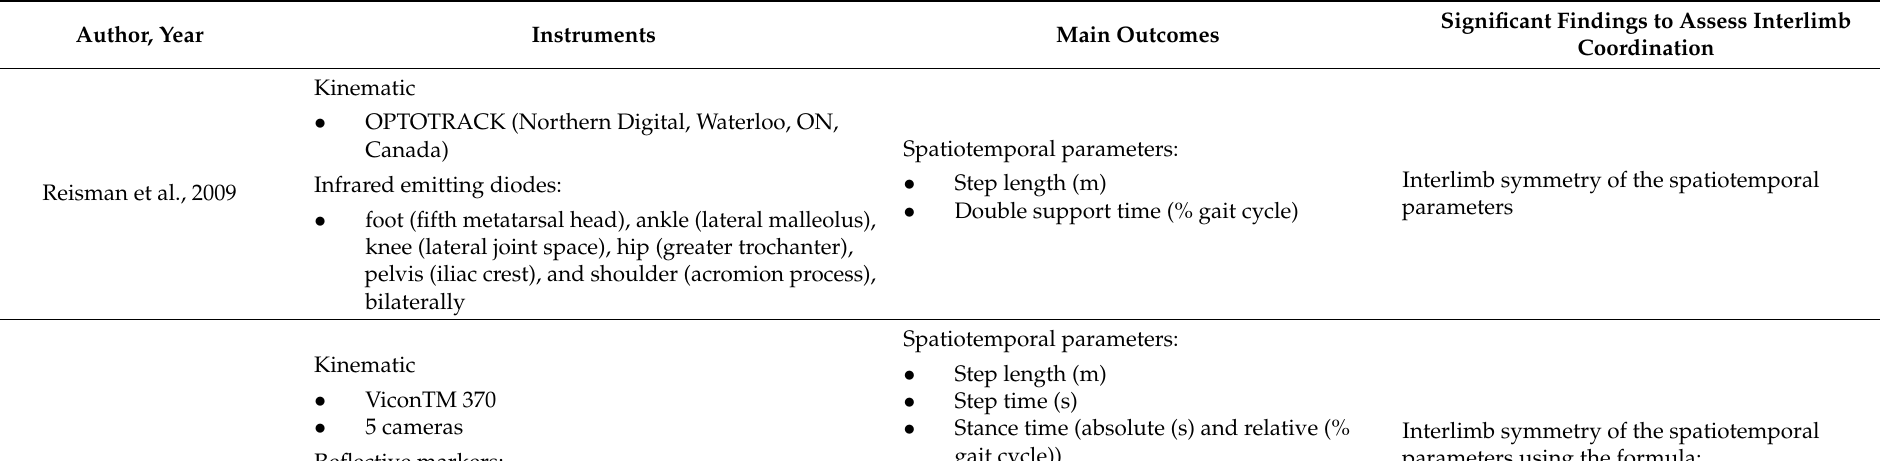
Table 2. Instruments, main outcomes, and significant findings to assess interlimb coordination, during